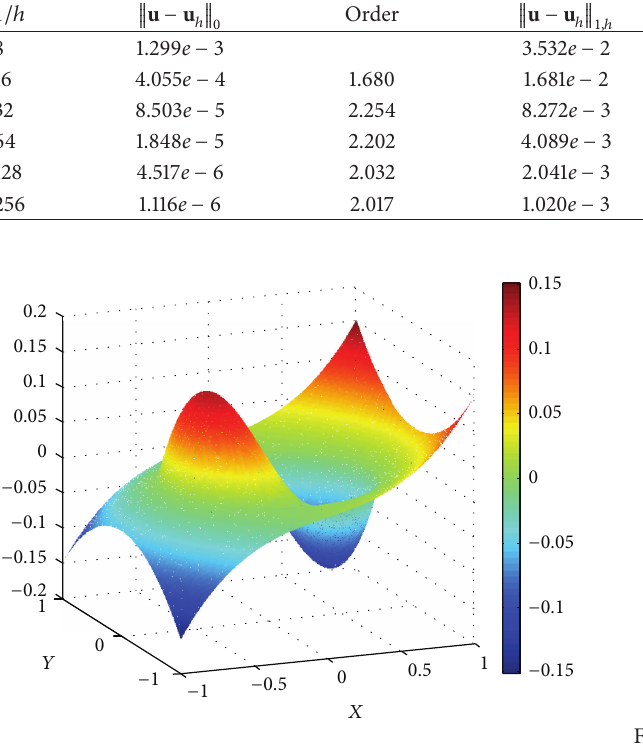
Figure 5: 𝑥 -component, 𝜇 − = 1, 𝜇 + = 10, 𝜆 = 100𝜇 .